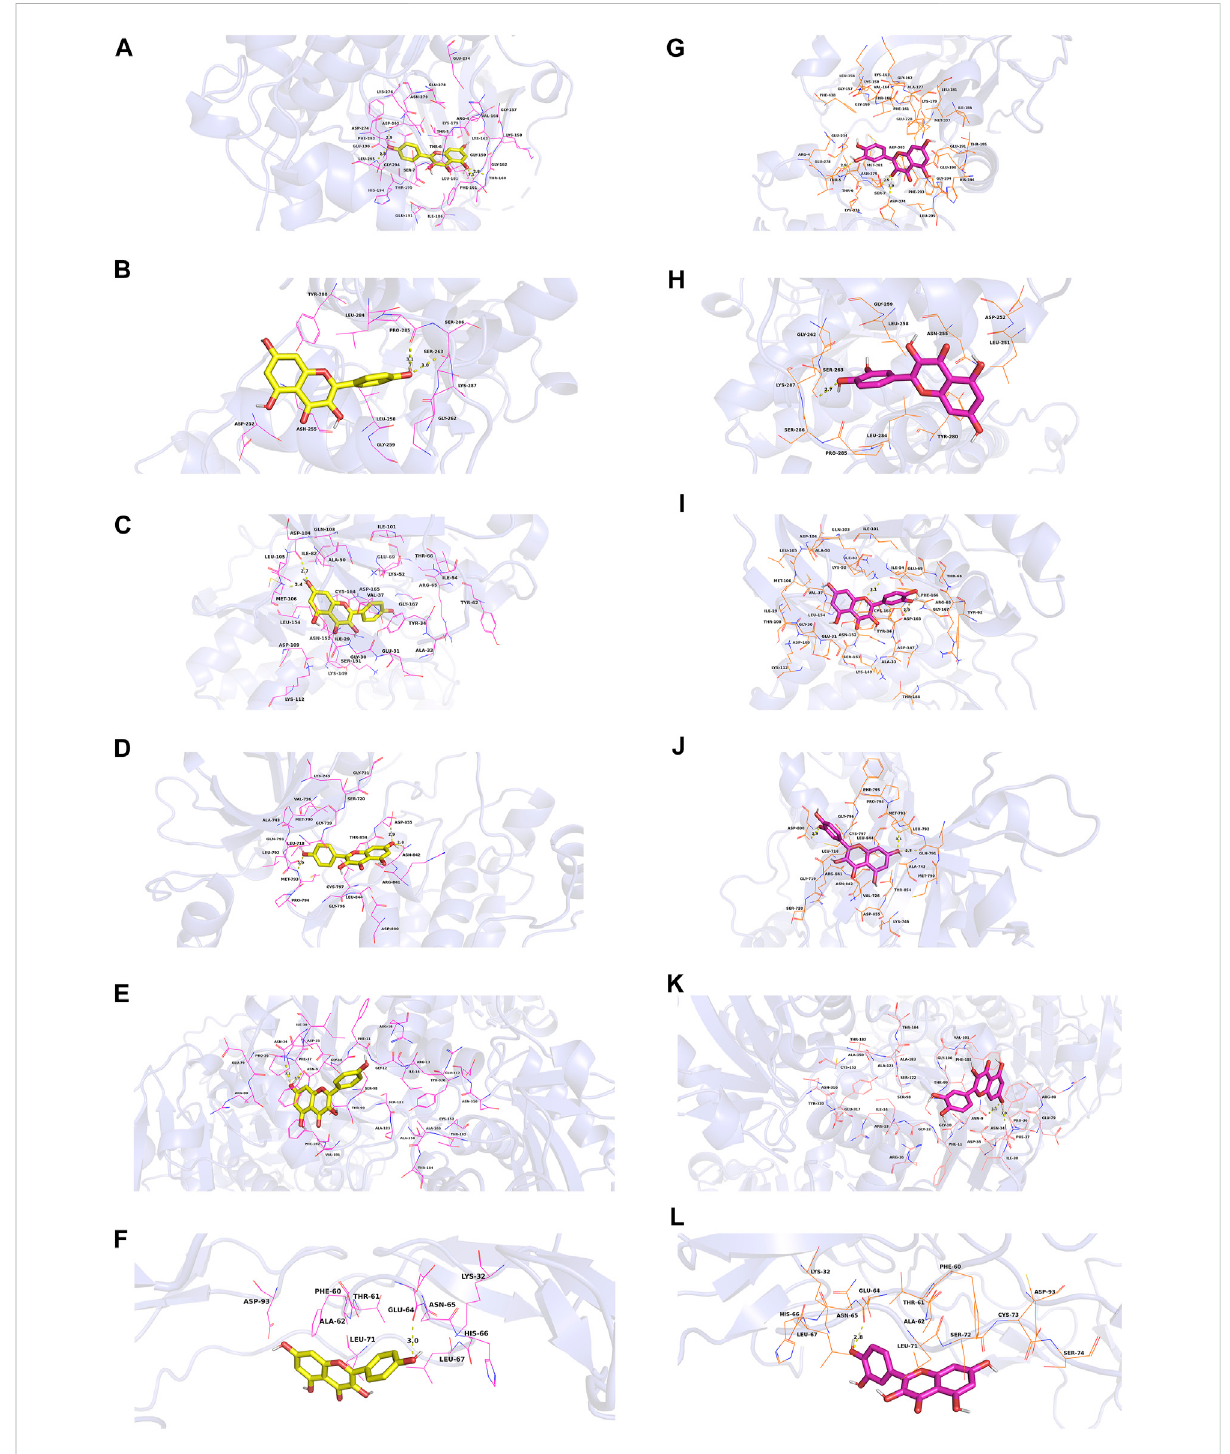
FIGURE 7 Molecular models of kaempferol and quercetin that bind to the predicted protein targets, shown as 3D diagrams. (A) Kaempferol-AKT1, (B) kaempferol-MAPK3, (C) kaempferol-MAPK1, (D) kaempferol-EGFR, (E) kaempferol-GAPDH, (F) kaempferol-TNF, (G) quercetin-AKT1, (H) quercetin- MAPK3, (I) quercetin-MAPK1, (J) quercetin-EGFR, (K) quercetin-GAPDH, (L)